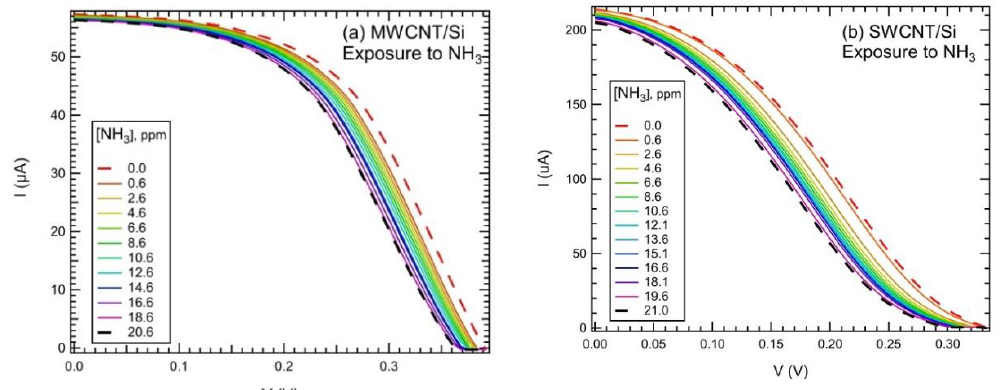
Figure 2. Effects of NH 3 exposure (in the testing chamber) on the current–voltage (I–V) curves of multiwalled CNT (MWCNT)/Si ( a ) and single-walled CNT (SWCNT)/Si ( b ) hybrid PV cells. Maximum concentration in ( a ) was 20.6 ppm, while it was 21.0 ppm in ( b ). Intermediate concentration values are indicated in the inset of each panel.